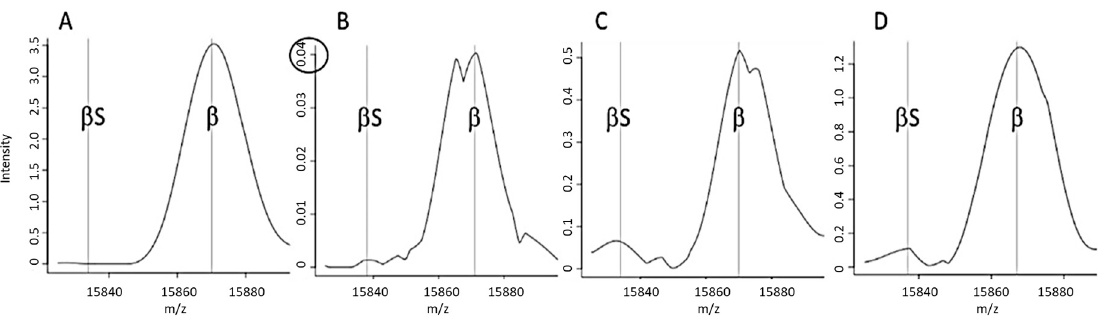
Figure 2. Examples of spectra tagged by a particular alert. ( A ) A “standard” FA spectrum that did not trigger an alert, ( B ) A spectrum tagged by an FA-a alert (an abnormally weak β chain peak), ( C ) a spectrum tagged by an FA-b alert (an abnormal β : β S intensity ratio), ( D ) A spectrum tagged by an FA-c alert (resolution of a putative peak for abnormal β S).